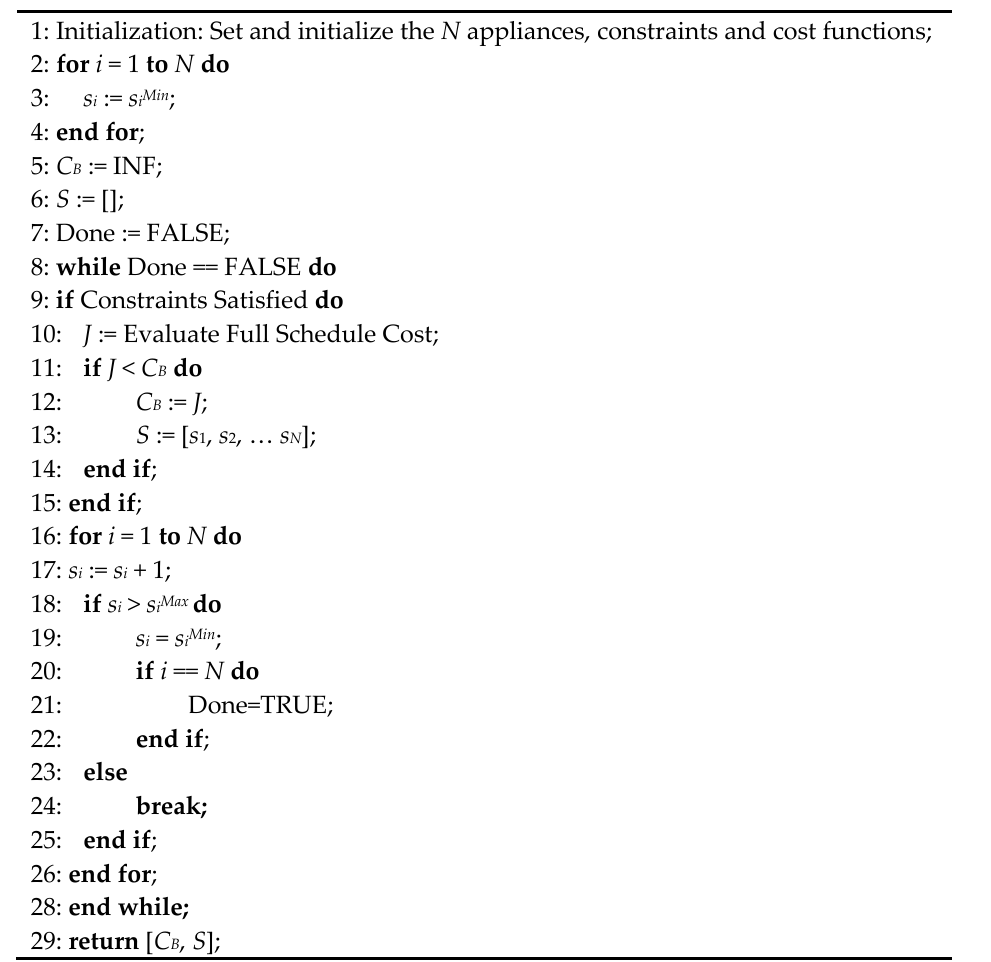
Algorithm 1. Exact Method.